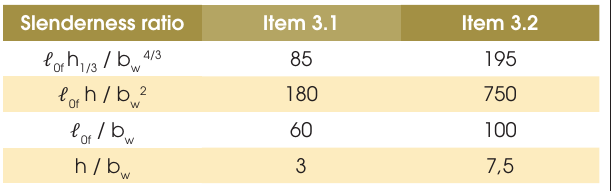
Table 6 – Comparison of slenderness